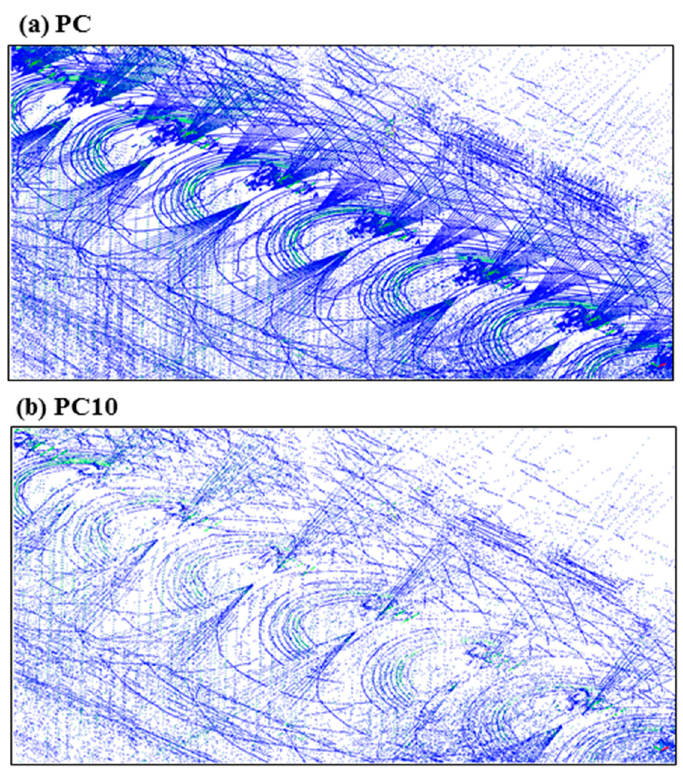
Figure 10. Example 1 of 3D point cloud: ( a ) original; ( b ) point cloud at 10% reduction level.